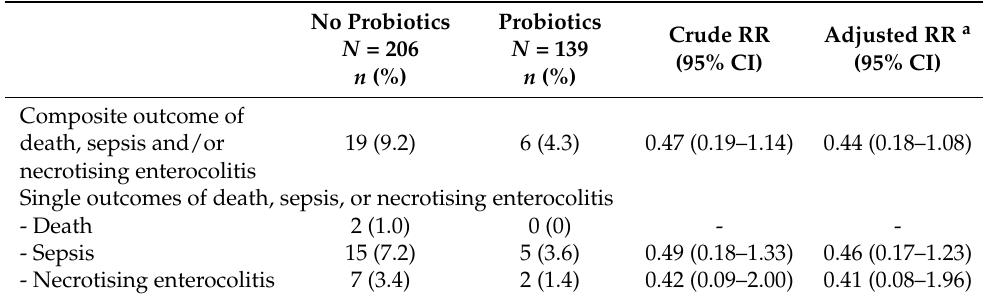
Table 2. Rates and risks of the composite outcome of death, sepsis, and/or necrotising enterocolitis, in 345 very preterm